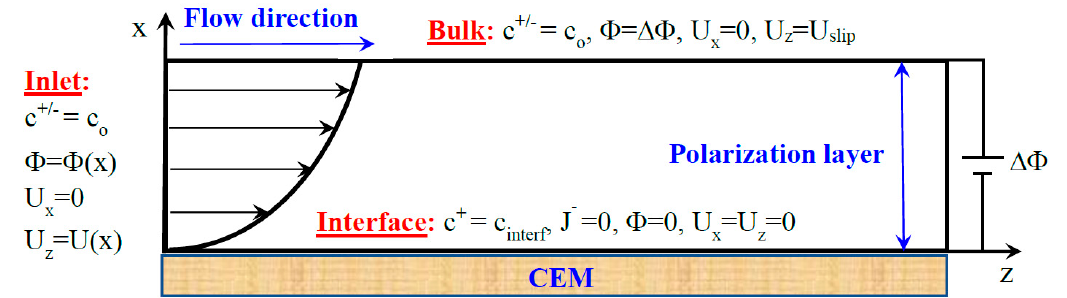
Figure 2. Schematic representation of the numerical model: an electric potential drop ∆Φ is imposed over the width of the electrolyte layer (polarization layer) lying between a bulk, containing an electrolyte solution of concentration c o and a cation exchange membrane at the surface of which the cation concentration c + and a non-flux of co-ions are imposed. A Poiseuille flow is imposed at the inlet.